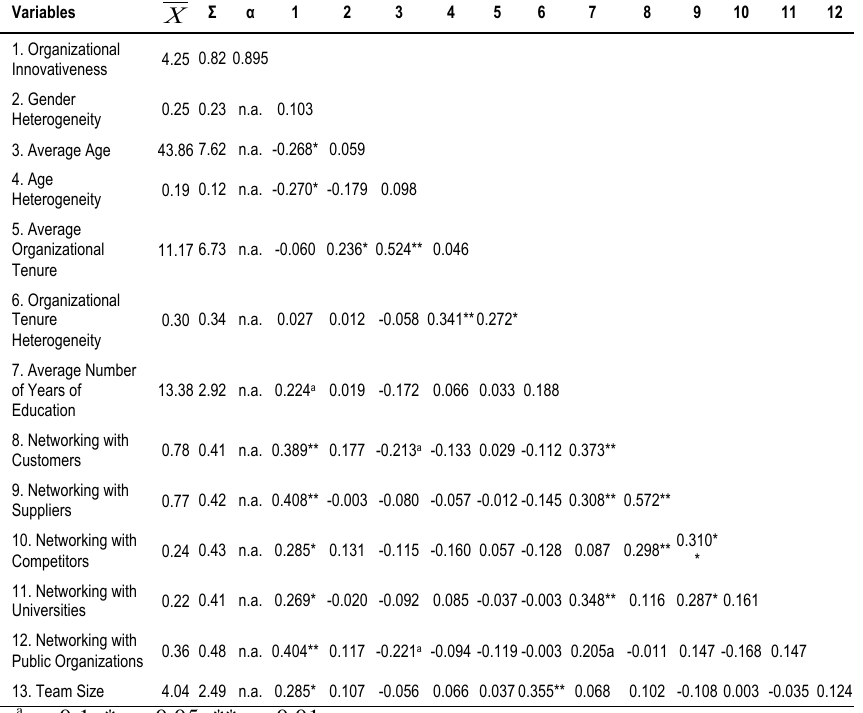
Table 2. Means, Standard Deviations, Alpha Coefficients and Intercorrelations for Variables.